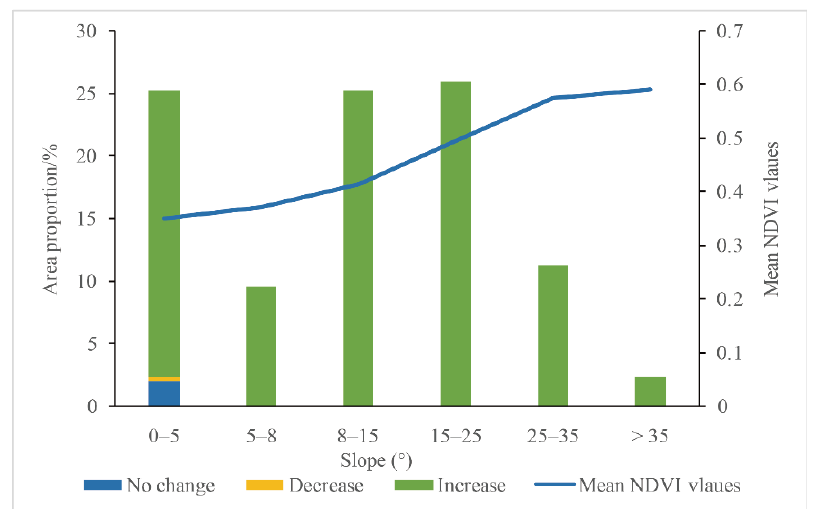
Figure 15. The relationship of NDVI change with slope in Shaanxi Province (Note: “No Change”, ”Decrease”, and “Increase” in the legend means the annual average NDVI change trend of Shaanxi Province, referring to the Figure 7).